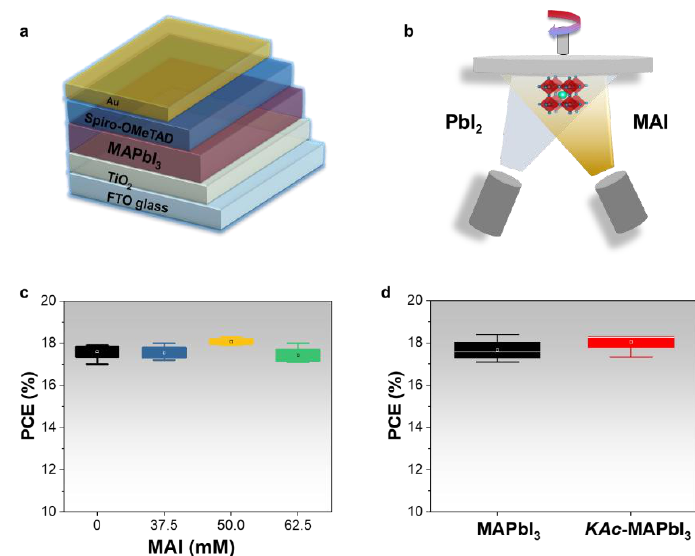
Figure 1. MAPbI 3 planar n-i-p device structure. ( a ) Schematic of perovskite solar cell device structure. ( b ) Schematic of the thermal co-evaporation of MAPbI 3 using methyl ammonium iodide (MAI) and lead iodide (PbI 2 ) precursors. ( c ) Power conversion efficiency (PCE) distributions as a function of the MAI concentration used for the spin coating treatment. ( d ) PCE distributions as a function of the potassium acetate (KAc) treatment.